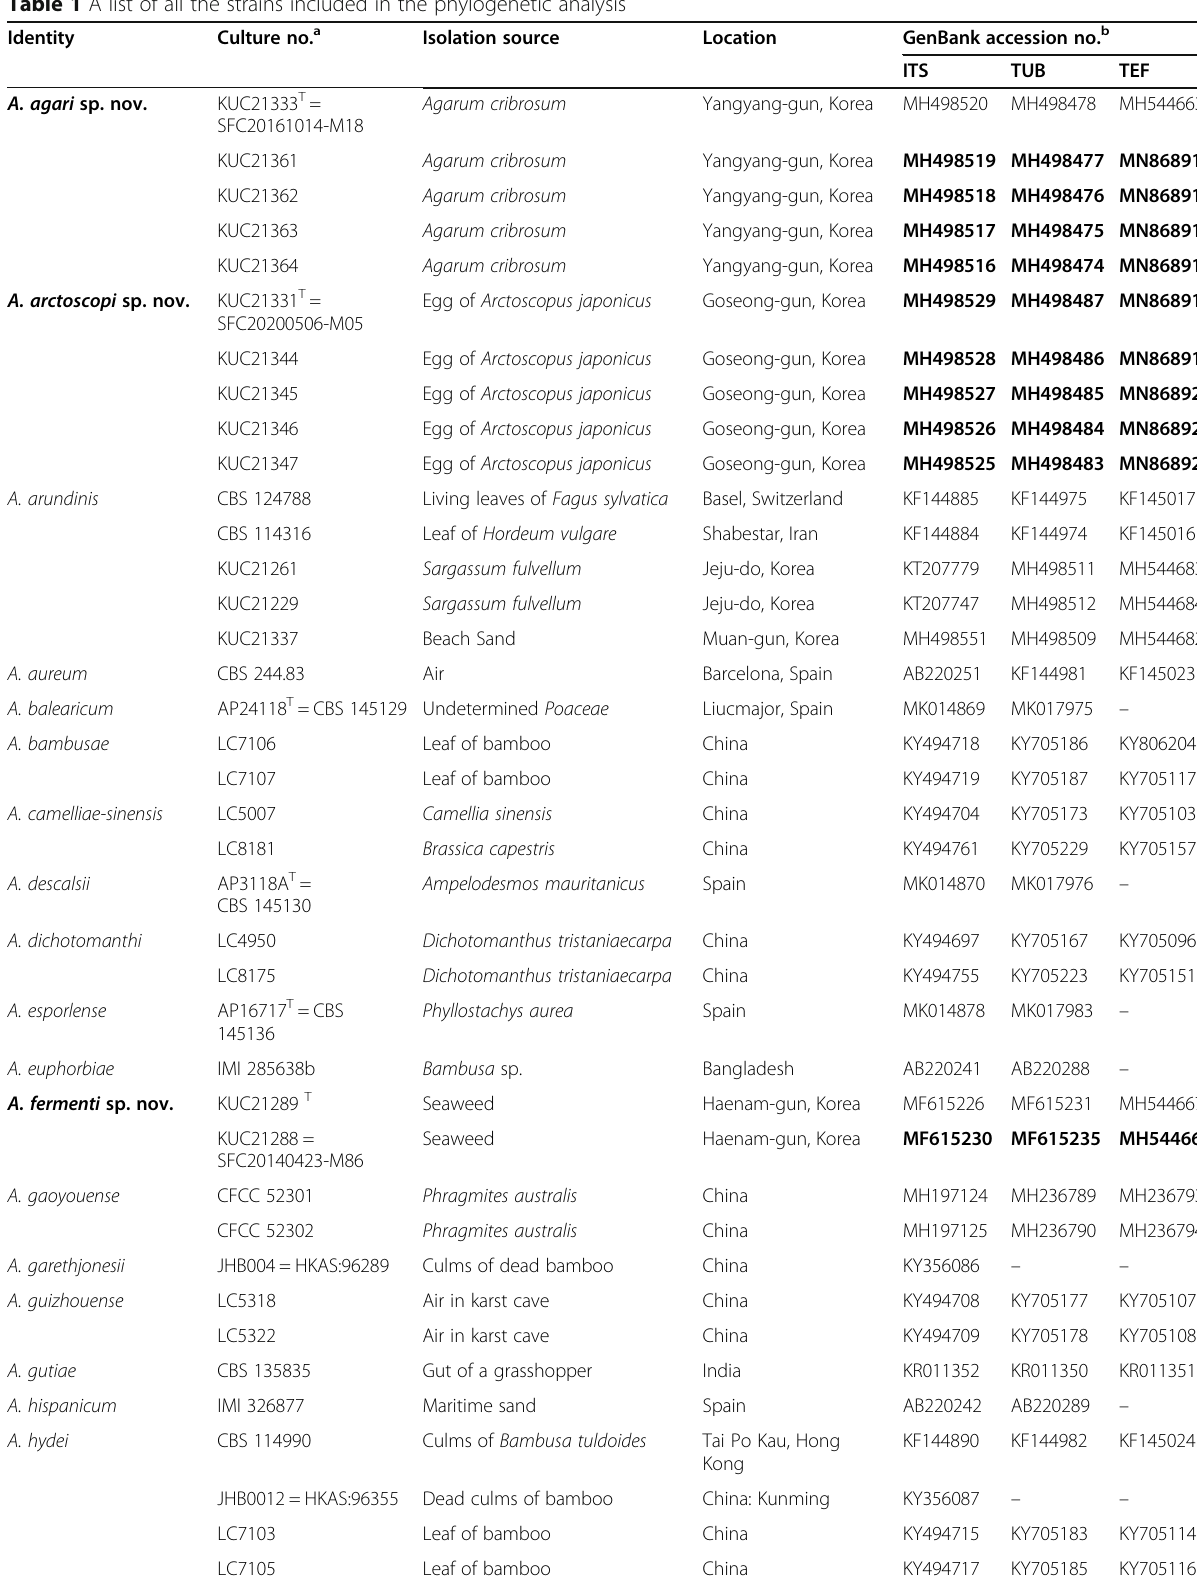
Table 1 A list of all the strains included in the phylogenetic analysis